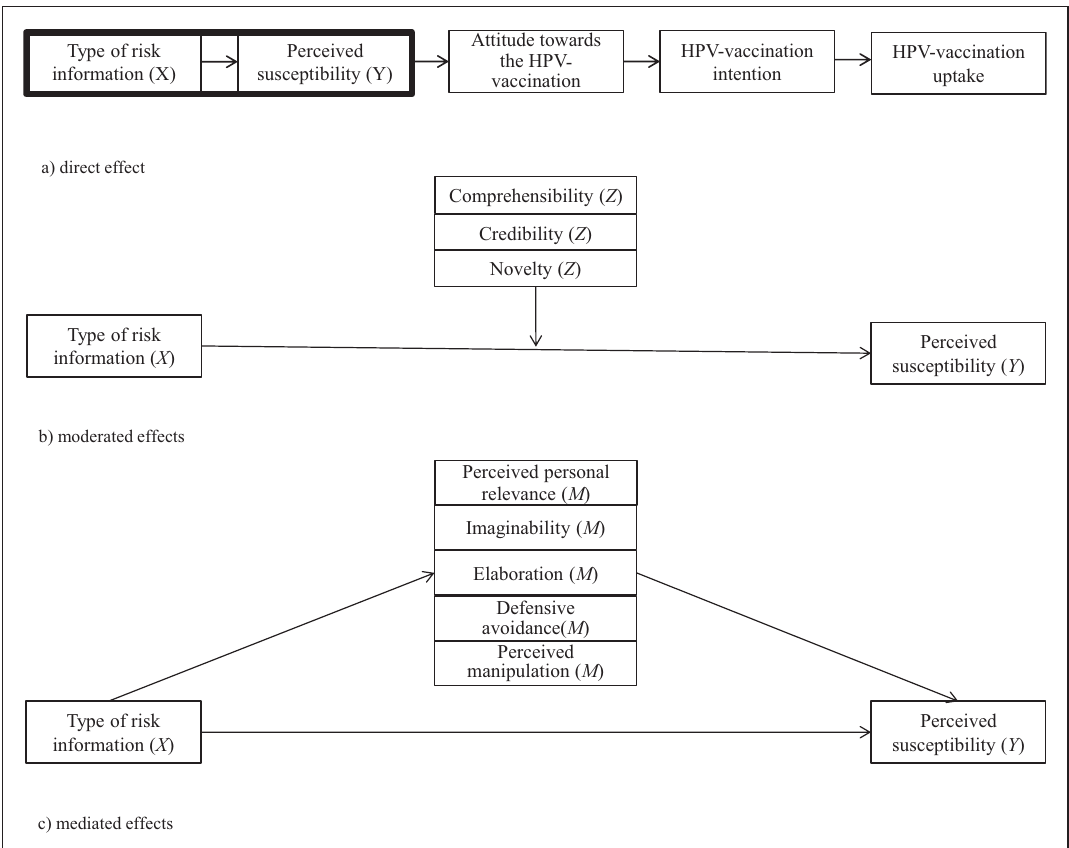
Figure 1: A schematic overview of the theoretical framework of perceived susceptibility in which the direct (a) , moderation (b) and mediation effects are depicted (c)